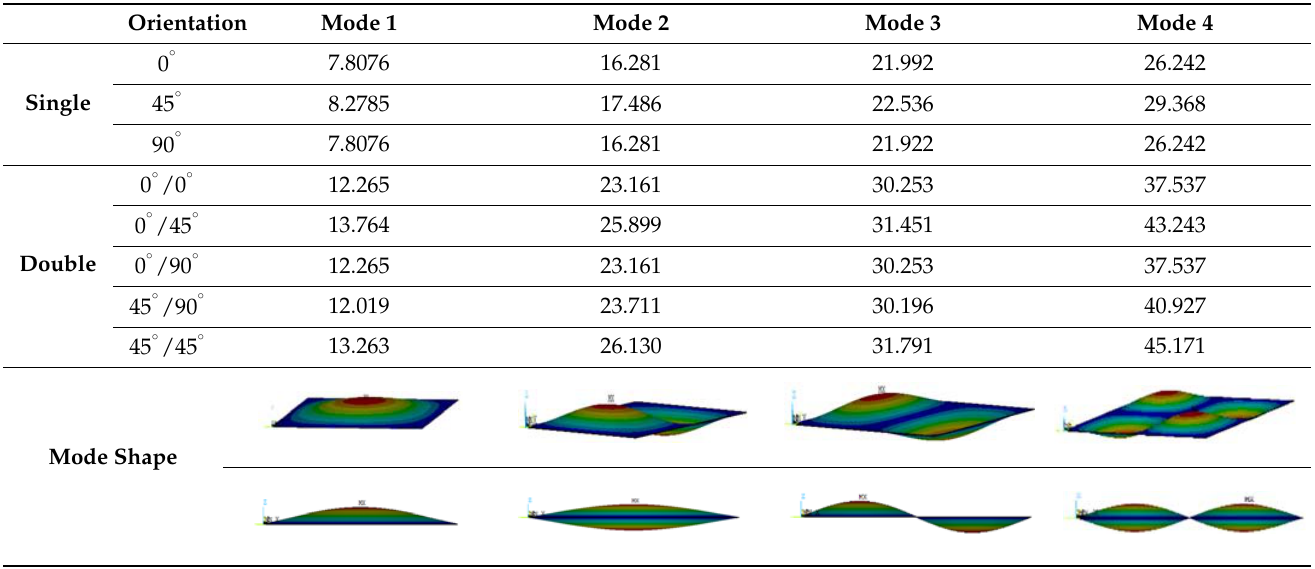
Table 4. Natural frequencies (Hz) and mode shapes of the composite plate.